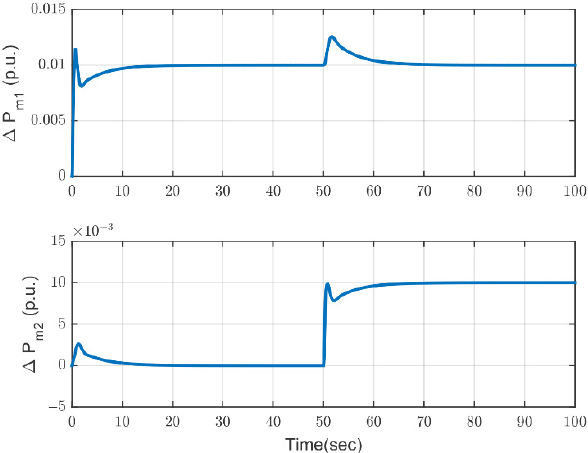
Figure 6. Deviation in mechanical power of the proposed LFC controller for unit step load disturbance.